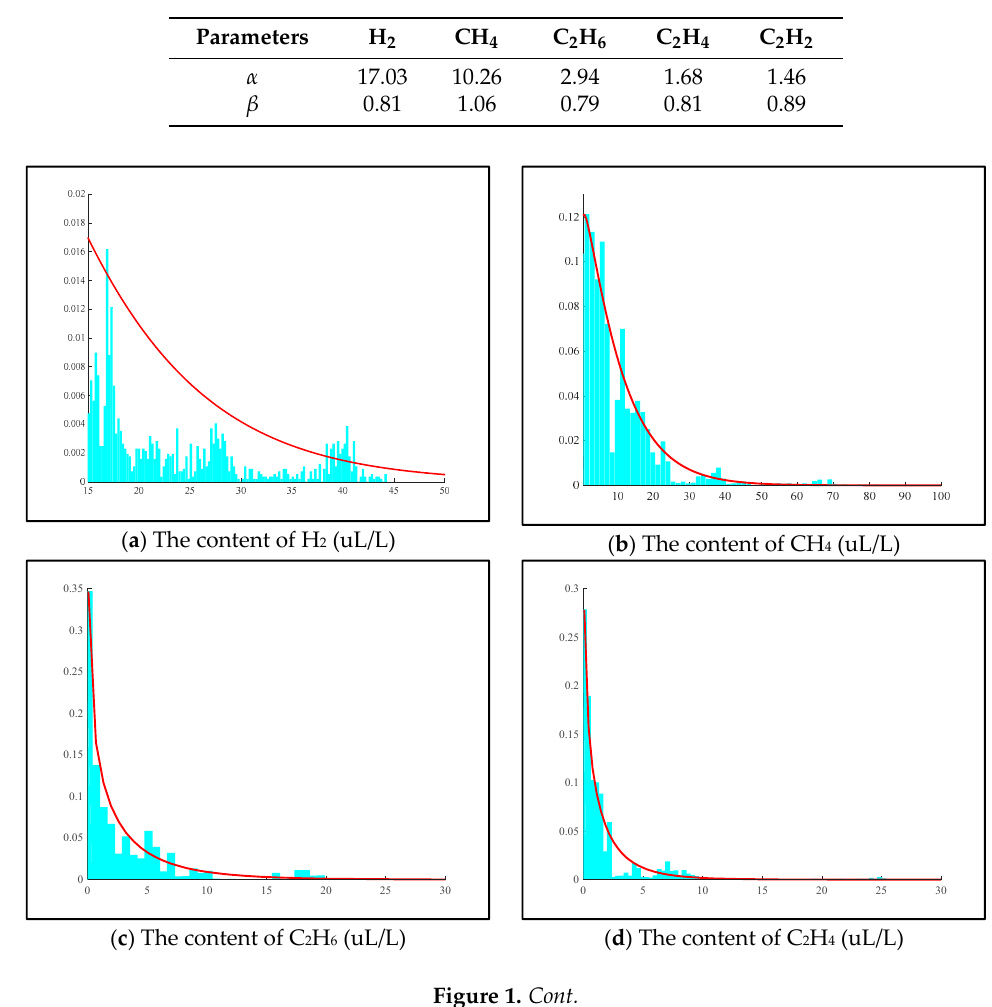
Table 1. The parameters calculation results of the Weibull model.